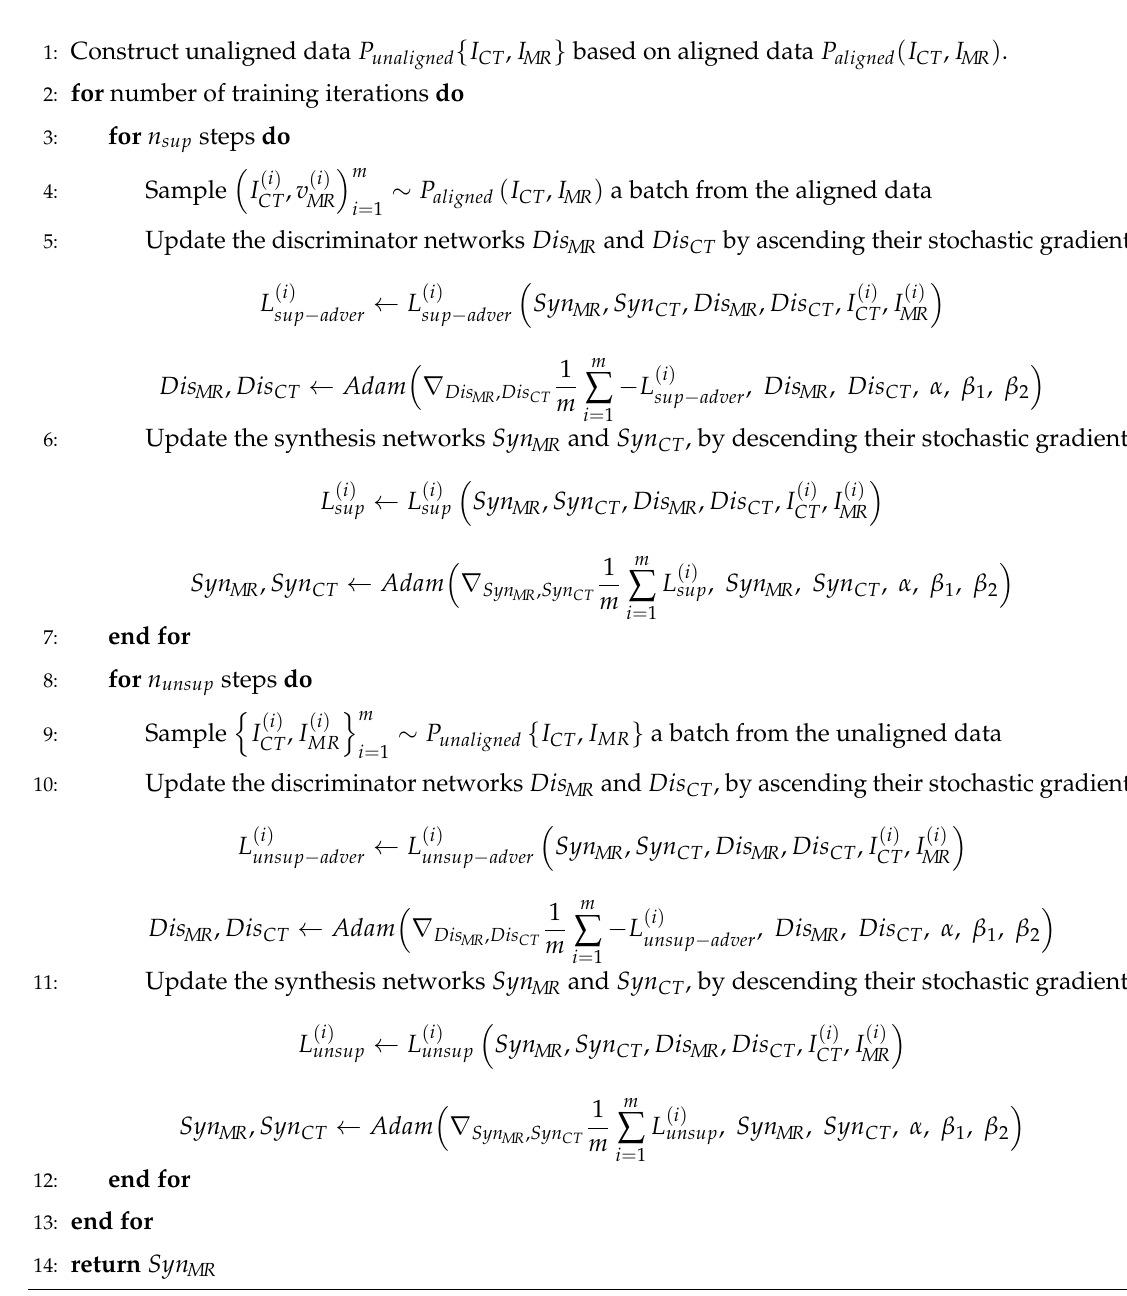
Algorithm 1 Mini-batch stochastic gradient descent training of DC 2 Anet. We used default values of m = 1, n sup = n unsup = 1, α = 0.0002, β 1 = 0.5, and β 2 = 0.999. Require: The batch size m , the number of alternative iterations between supervised learning and unsupervised learning n sup and n unsup , the learning rate α , and Adam hyperparameters β 1 and β 2